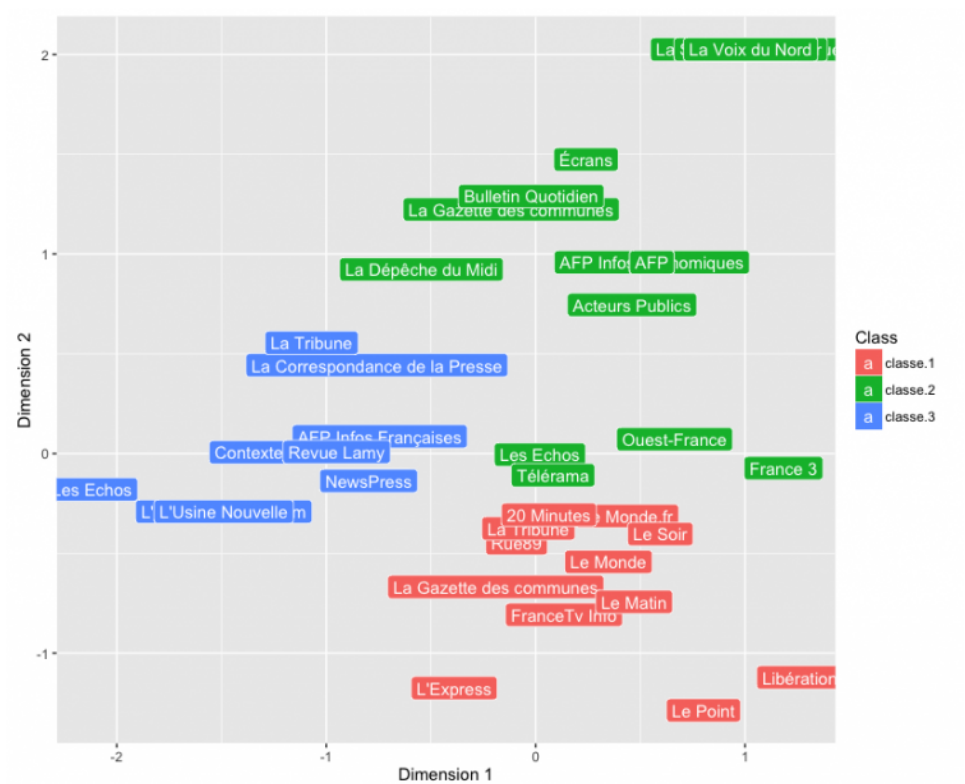
Figure 4: Cluster analysis in the French corpus The closeness of each term and each media on the graph theoretically indicates their degree of affinity: terms which share a very close position would appear both very frequently in the same documents; in the same manner, media located on a similar coordinate will tend to use a similar array of terms. The blue and the green clusters mostly reflect inherent organisational news dynamics. Most of the "blue" media are specialised outlets that cover the evolution of law with a great deal of detail (such as Contexte , with p= 0.002). Conversely, "green" media are much more generalist and tend to extensively reuse news agency content. All the regional dailies are within this range and a closer look to the corpus reveals numerous identical wires taken from Agence France Presse (with p =